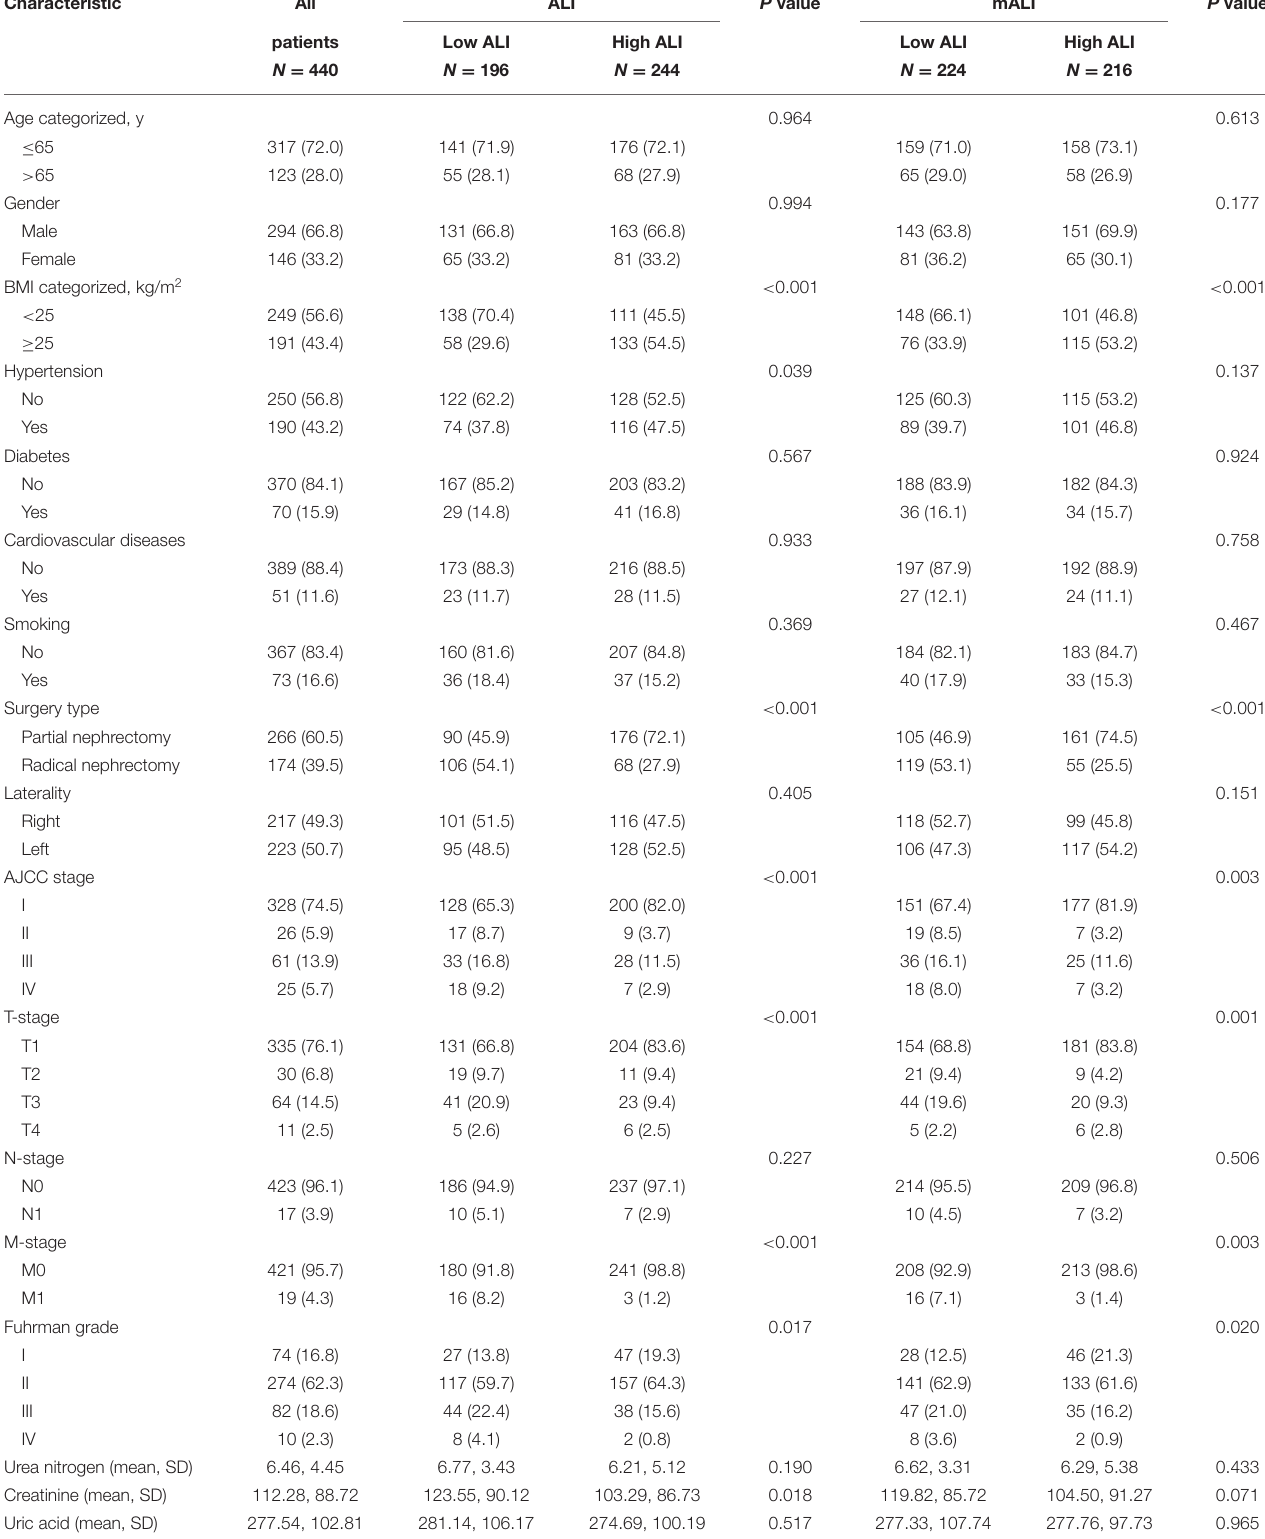
TABLE 1 | Clinical characteristics of the patients according to ALI and mALI before PSM.